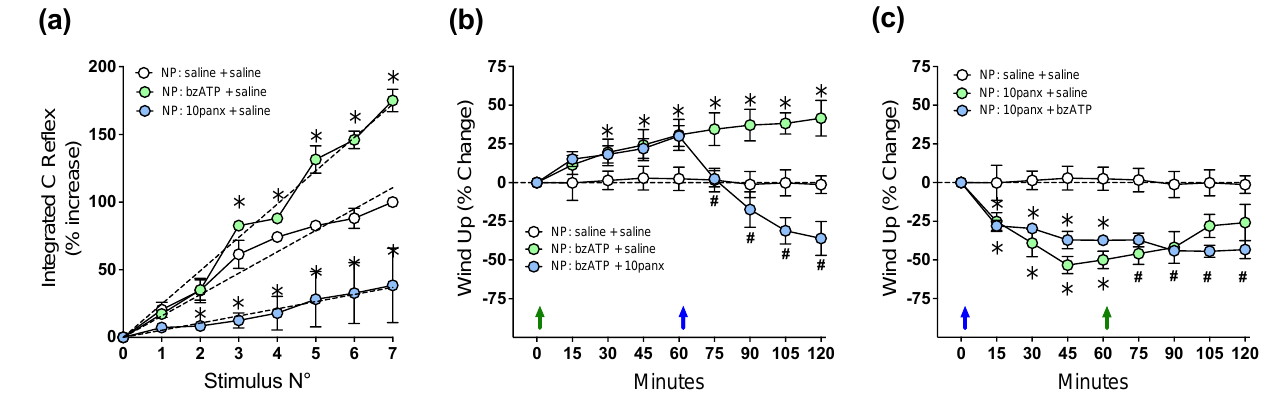
Figure 4. Effect of intrathecal administration of BzATP followed by 10panx, or 10panx followed by BzATP, on C-reflex wind-up activity of neuropathic (NP) rats. NP rats receiving saline served as controls. Values are means ± SEM, n = 6 rats in each group. ( a ) Figure depicting data processing for determining spinal cord wind-up scores in neuropathic animals, as in Figure 2a. The slope of the least-squares regression line represents a control wind-up score, prior to any administration of drugs or saline. Thereafter, a 10 µL i.t. injection of either saline solution (white circles), 150 µM BzATP (light green circles) or 300 µM 10panx (light blue circles) was performed, and a new series of seven repetitive electric stimulations (1 Hz) was applied 30 min after, and the wind-up scores calculated from the slopes of the respective least-squares regression lines. The procedure was repeated using 6 animals per group, and the average data is presented as Figure 4a. Values are means ± SEM of data averaged from 6 rats per group, and the slopes of regression curves (dashed lines) represent wind-up scores for each drug treatment: 15.80 ± 0.58 (saline), 24.62 ± 0.58 * (BzATP), and 5.28 ± 0.63 * (10panx), the difference between slopes being statistically significant (one-way ANOVA, F 2,15 = 378.5; * p at least <0.0001 with respect to saline group, Bonferroni multiple comparisons test). ( b ) Time course of wind-up activity (expressed as % change) in neuropathic rats immediately before and 15, 30, 45, 60, 75, 90, 105 and 120 min after an i.t. injection of BzATP or saline at time 0 (violet arrow), followed by an i.t. injection of 10panx or saline at time 60 min (blue arrow). Two-way repeated measures ANOVA revealed a “time” effect (F 1.386,20.78 = 3.701). Intragroup analysis: * p at least <0.05 with respect to time zero min, # p at least <0.05 with respect to time 60 min, Bonferroni multiple comparisons test). Note the increased wind-up activity after BzATP, and the counteracting effect of 10panx. ( c ) Time course of wind-up activity (% change) in neuropathic rats after the inverse scheme of drug administration, i.e., an i.t. injection of 10panx or saline at time 0 (blue arrow), followed by an i.t. injection of BzATP or saline at time 60 min (violet arrow). Two-way repeated measures ANOVA revealed